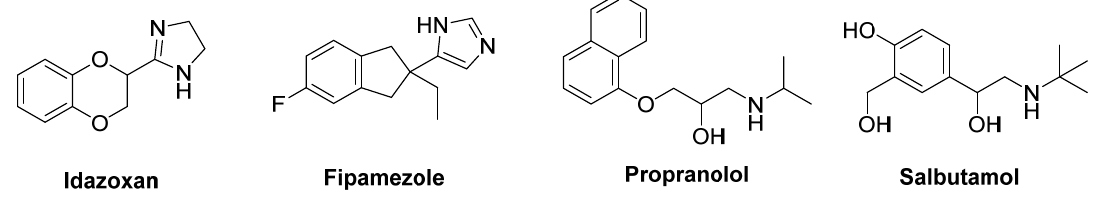
Figure 10. Noradrenergic receptor ligands.